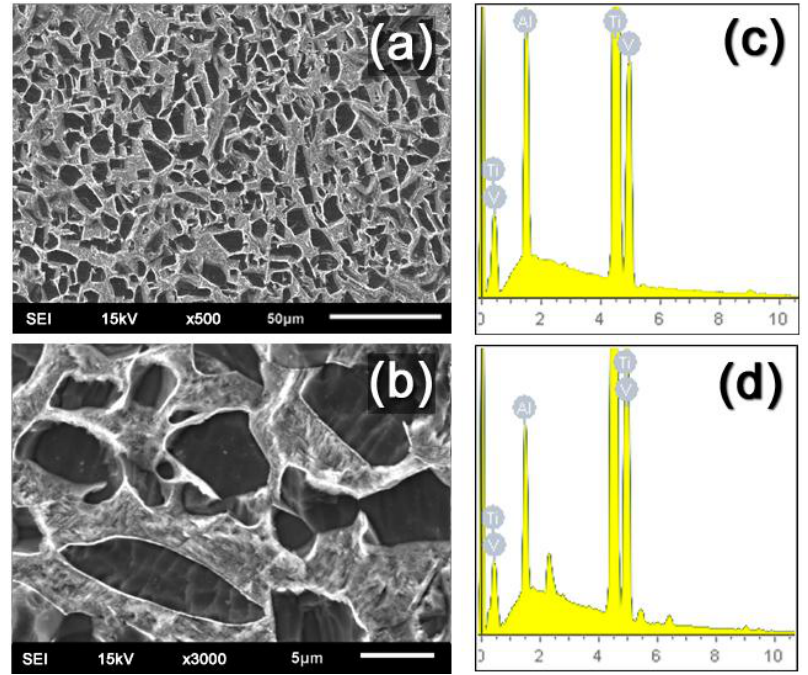
Figure 12. SEM/EDX for the as-annealed Ti-54M sample at 940 ◦ C and after five days of immersion in 2 M HCl solutions, ( a , b ) are the SEM images; ( c , d ) are the EDX profiles for the area shown in ( a , b ),